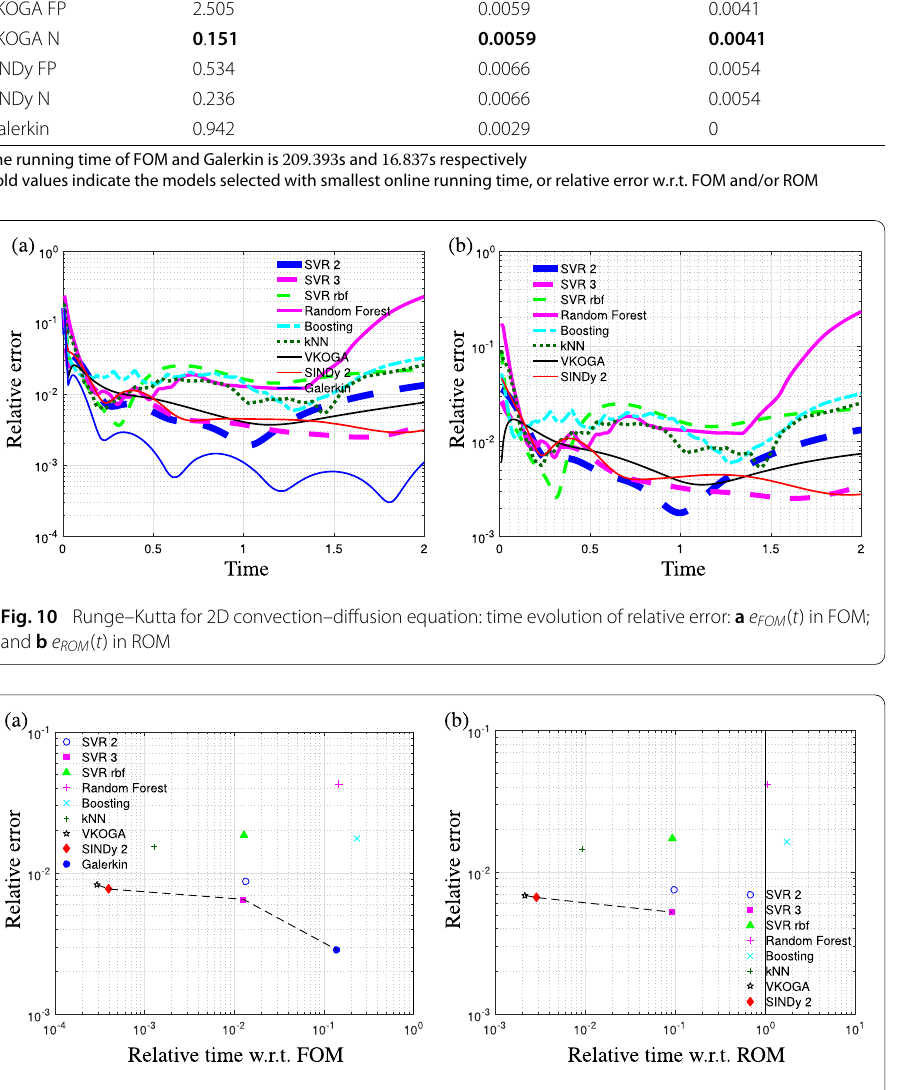
Fig. 11 Pareto frontier of relative error with respect to the relative running time using 4th-order Runge–Kutta for 2D convection–diffusion equation: a e FOM vs. τ FOM in FOM; b e ROM vs. τ ROM in